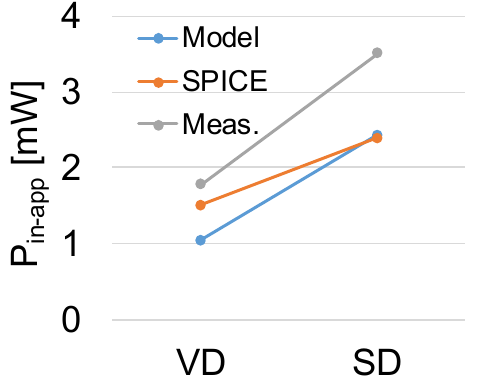
Figure 21. Measurement result under 50 Ω system at P out of 100 µ W ( 1 V, 100 µ A ) . Figure 21. Measurement result under 50 Ω system at   of 100  (1 ,100 ) .